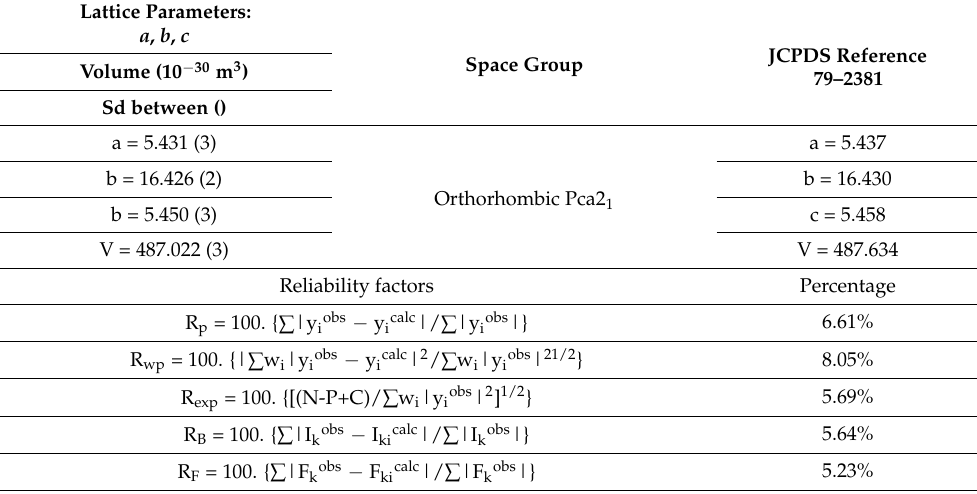
With N, P, and C denoting the number of observations, parameters, and constraints,